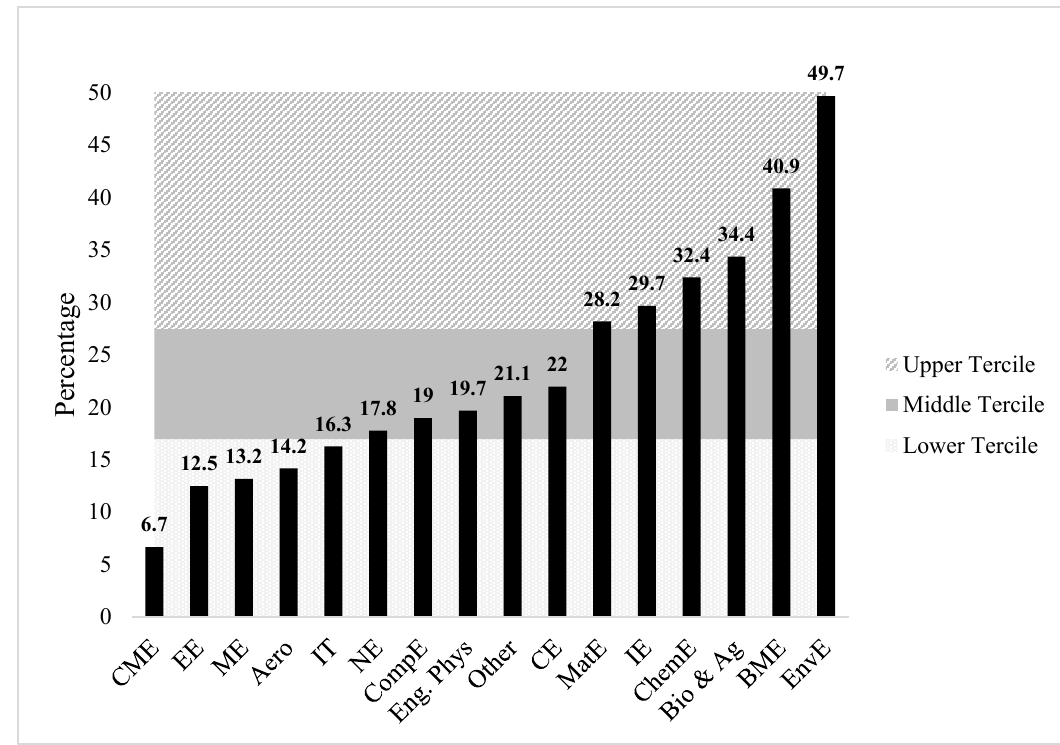
Figure 1. Percentage of Women in Engineering Disciplines in the 2014–2015 Academic Year (Yoder 2015). Abbreviations are as follows: CME = Construction Management Engineering, EE = Electrical